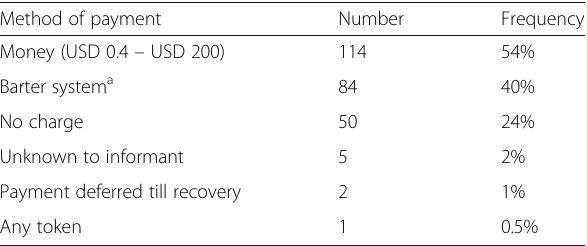
Table 3 Payment Methods for the Services of Traditional Healers Method of